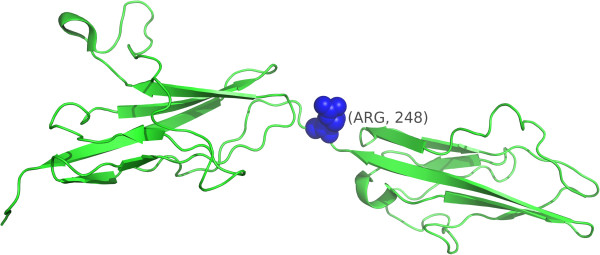
FGFR3 clustering. The FGFR3 structure (PDB ID: 1RY7) where residue 248 is highlighted blue.